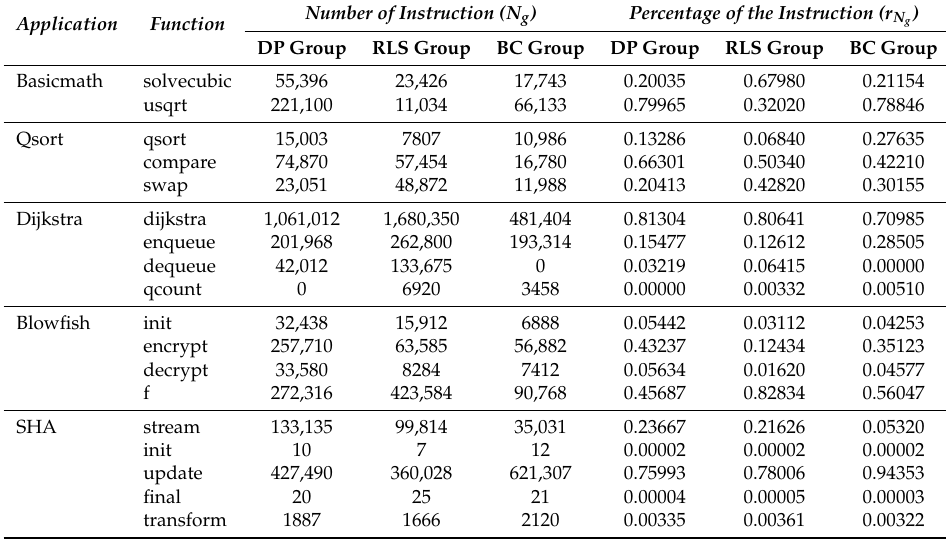
Table 6. Benchmark